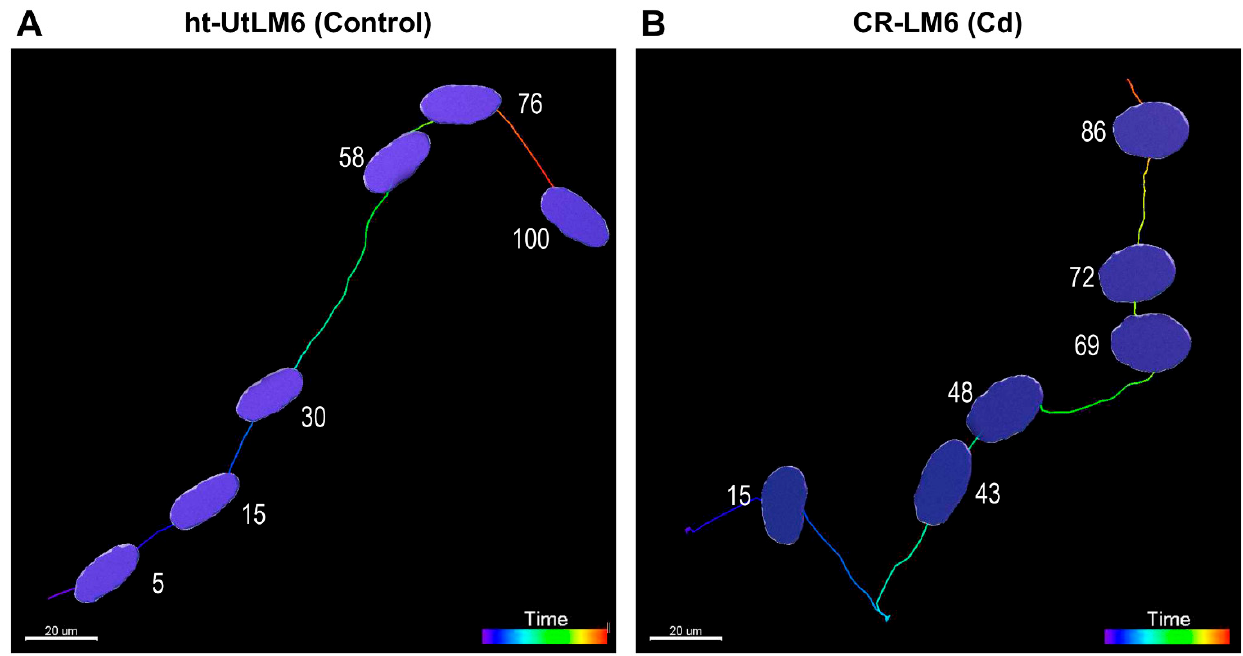
Figure 7. Cd exposure altered orientation of nuclei along migration tracks. The superimposed images show the location, shape, and orientation of nuclei. ( A ) The longest principal axis of ht-UTLM6 nucleus aligned with the direction of migration track at frames 5, 15, 30, 58, 76, and 100. ( B ) The longest principal axis of CR-LM6 nucleus was misaligned and occasionally perpendicular to the direction of migration track at frames 15, 69, 72, and 86. For nuclear orientations at all the time points, refer to supplementary videos (1 and 2). Scale bar = 20 µm.